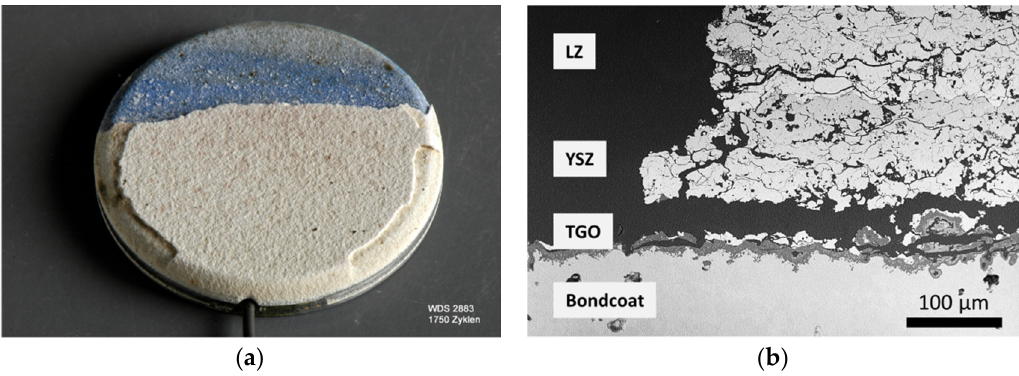
Figure 10. ( a ) Double ‐ layer sample, LZ sprayed with TriplexPro™ ‐ 210 at low power (22 kW) and with Ar–He plasma gas mixture (spray distance 150 mm, powder 322 I, after 1750 thermal cycles; ( b ) back ‐ scattered electron image of the cross ‐ section.